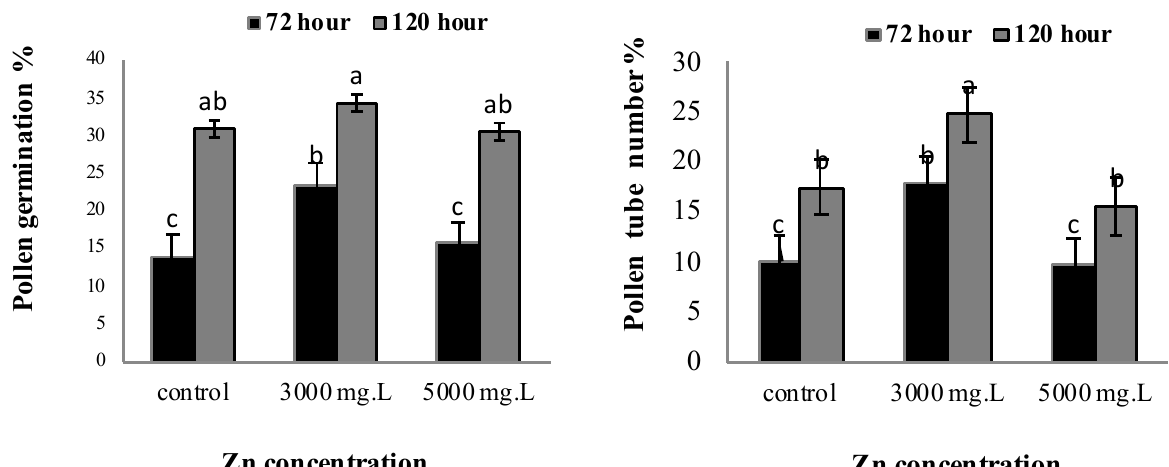
Fig. 7. The interactions between time and Zn concentration on the pollen tube number in the beginning of style. Means in each col- umn, followed by similar letter (s) are not significantly different at 1% probability level.